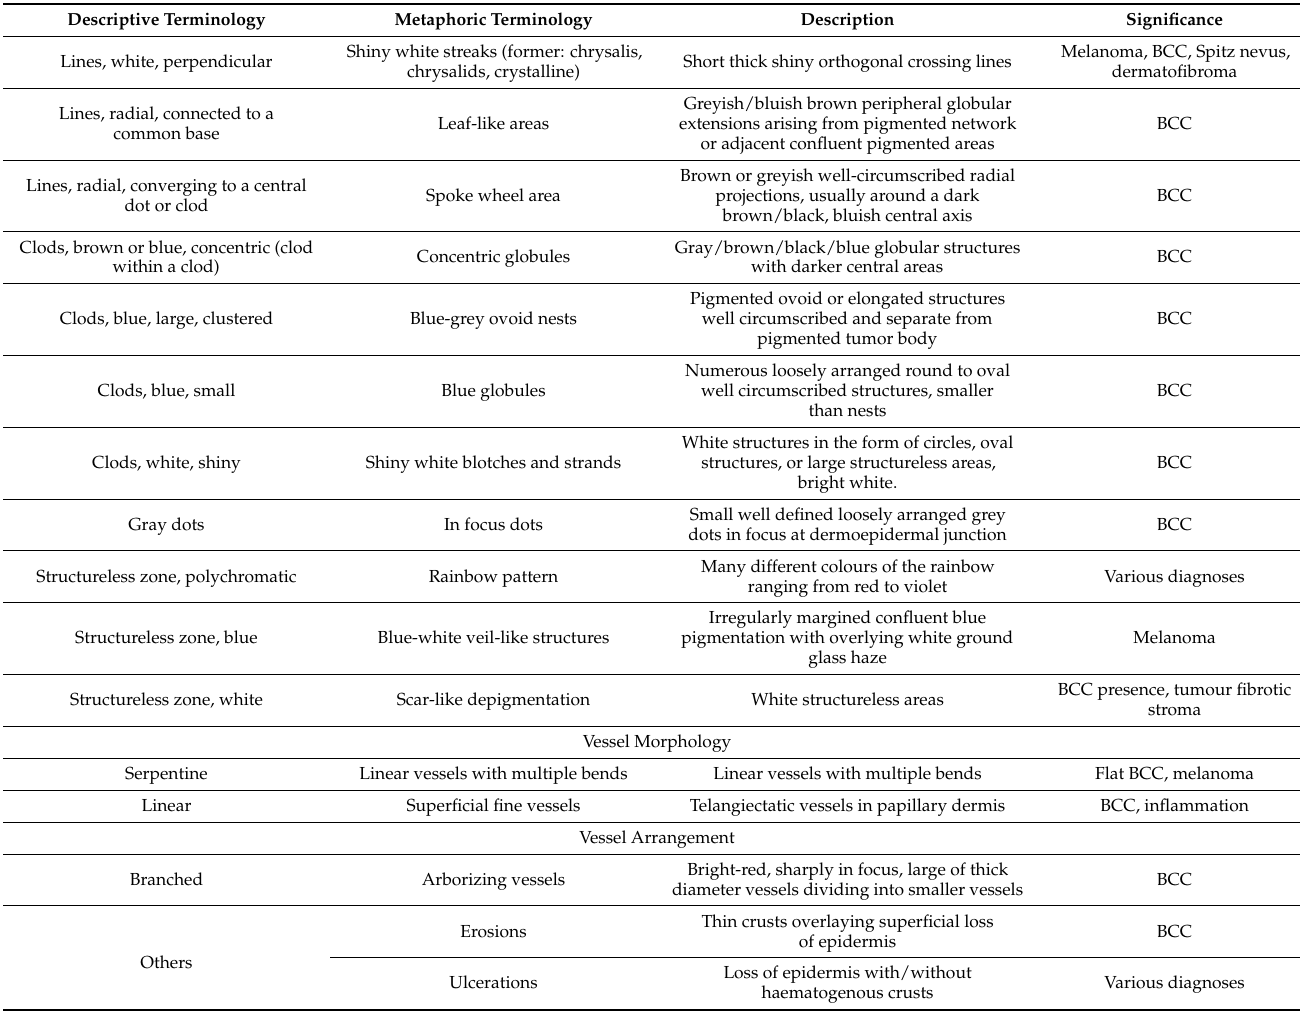
Table 3. Dermoscopic structures of BCC-associated criteria (16 features) ranked according to Lallas et al. [8] and Tognetti’s et al. [23] in own modification based on dermoscopic terminology from IDS